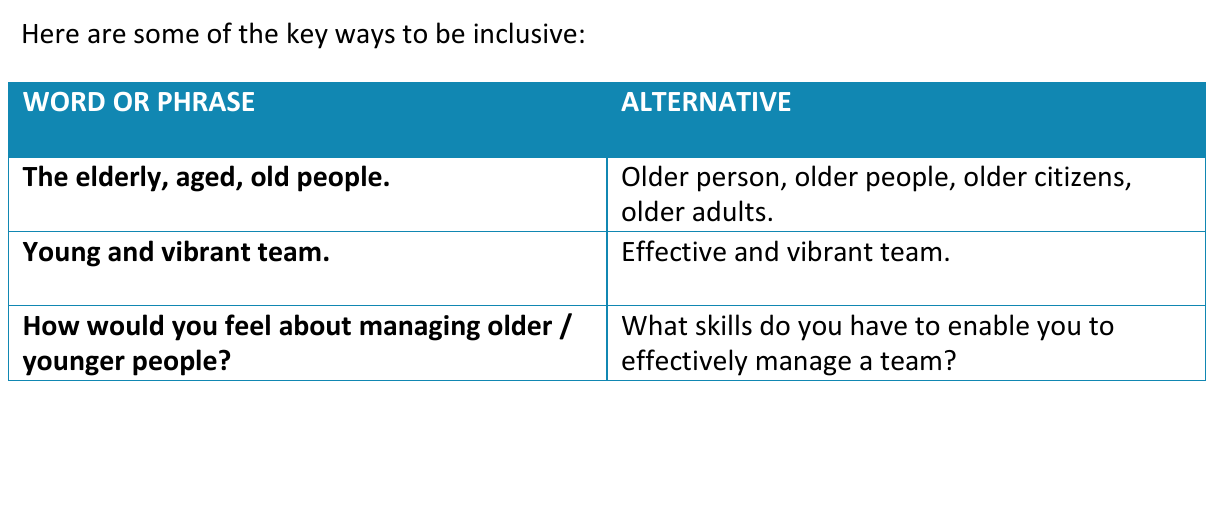
Page | 24 | Words Matter: Guidelines on Using Inclusive Language in the